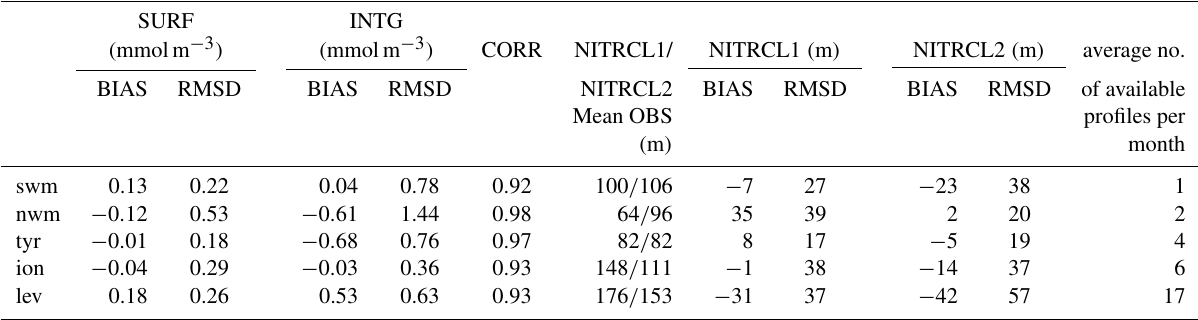
Figure 10. Time evolution of BGC-Argo float 6901768. (a) Trajectory of the BGC-Argo float (red dots) with deployment position (blue cross); Hovmöller diagrams of nitrate concentration (mmolm − 3 ) from float data (b) and model outputs (c) matched-up with float position for the period 2016–2017. Computation of selected skill indexes for model (solid line) and float data (dots): nitrate concentration at surface (SURF, d ) and 0–200m vertically averaged concentration (INTG, e ), correlation between vertical profiles (CORR, f ), depth of the nitracline computed as NITRCL1 (blue), and NITRCL2 (red; g ). Table 4. Averages of the nitrate indicators based on the BGC-Argo floats and model comparison for the period January 2016–December 2017. The indicators are the correlation between model and BGC-Argo float data (CORR), the BIAS and RMSD of the surface (SURF) and of the 0–200m vertically averaged (INTG) nitrate concentration, and the BIAS and RMSD of the depth of the nitracline computed as NITRCL1 and NITRCL2. Statistics are computed for selected aggregated sub-basins. For a reference, the mean value of NITRCL1 and NITRCL2 estimated from BGC-Argo data is included (Mean